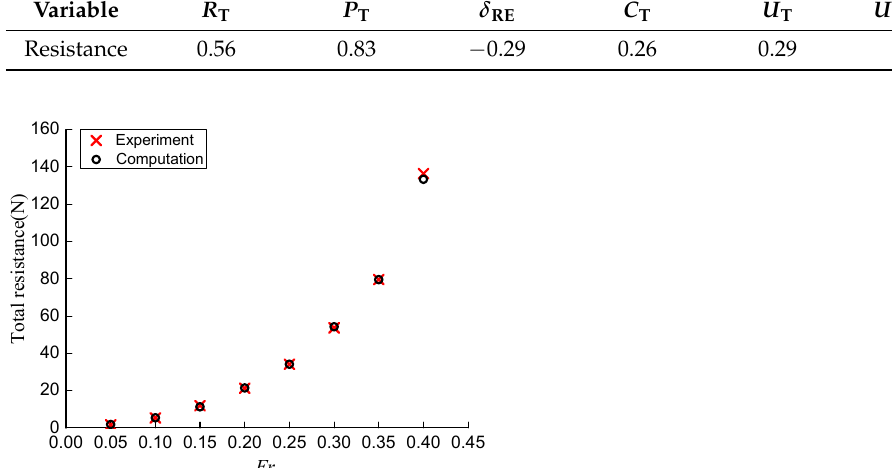
Table 7. Results of time dependence study for intact ship ( Fr = 0.28).